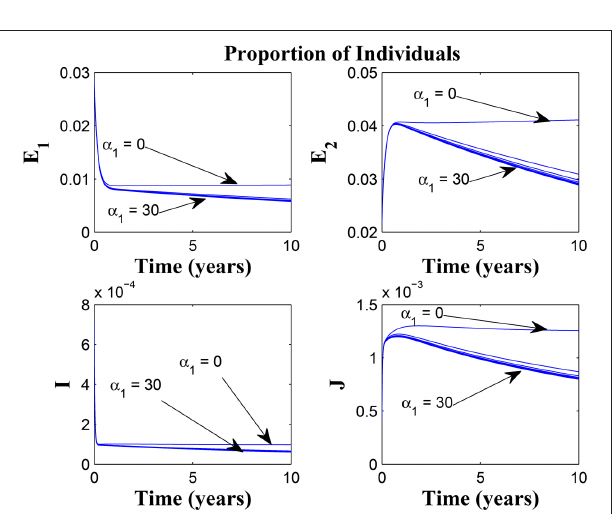
FIGURE 8 | Simulations of model (3) showing the number of infected individuals. Here, the awareness rate for the susceptible individuals ( α 1 ) is varied from 0 to 30 with θ 1 = 20 , θ 2 = 1 and π = 30